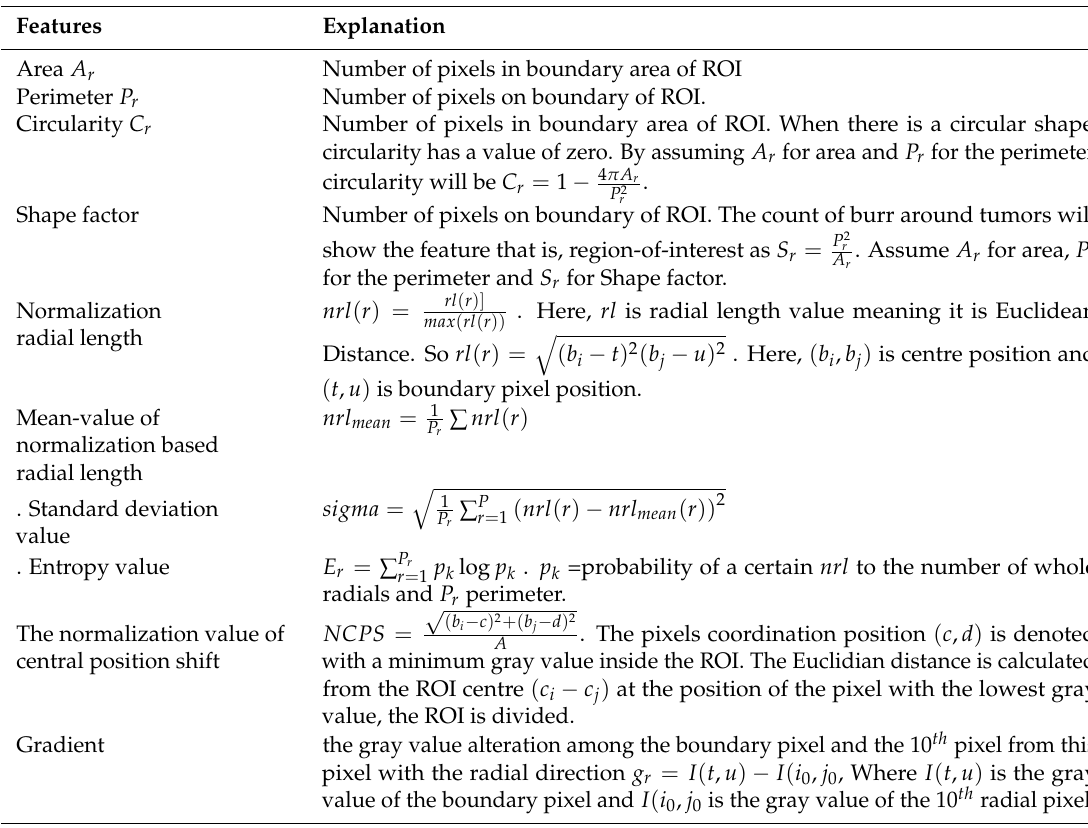
Table 1. Features for Segmentation.